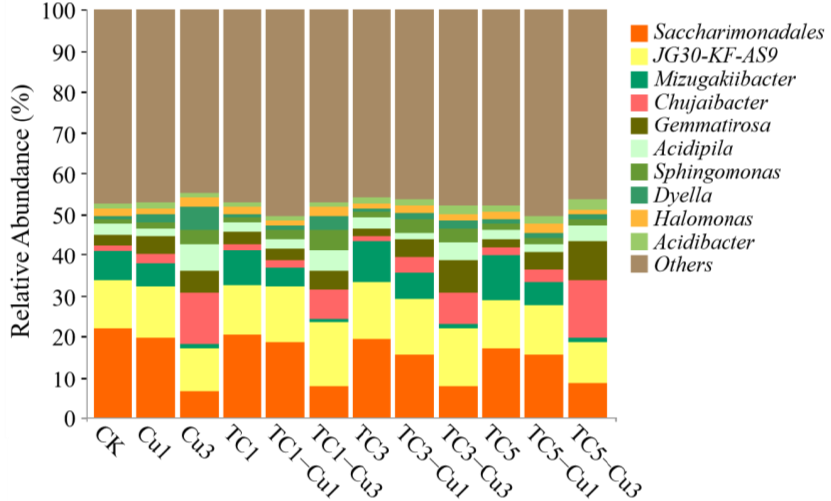
Figure 5. Relative abundance of soil bacterial communities at the genus level under TC and Cu con-